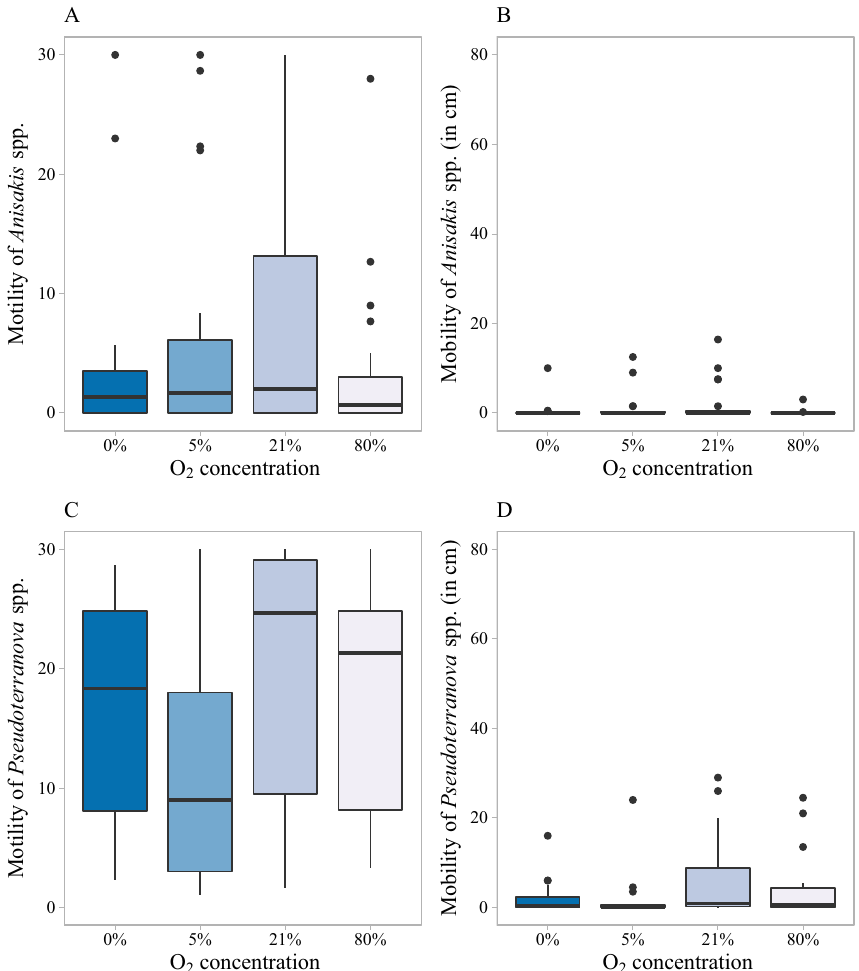
Figure 4. Effect of O 2 on larval motility and mobility at 12 ℃ during the first 30 min. (A) Motility of Anisakis spp., (B) mobility of Anisakis spp., (C) motility of Pseudoterranova spp. and (D) mobility of Pseudoterranova spp. under different O 2 conditions. The box consists of the upper quartile, median and lower quartile. The whiskers are drawn up to the highest or lowest observed point from the dataset that falls within 1.5 times the interquartile range. Observations beyond the end of the whiskers are plotted